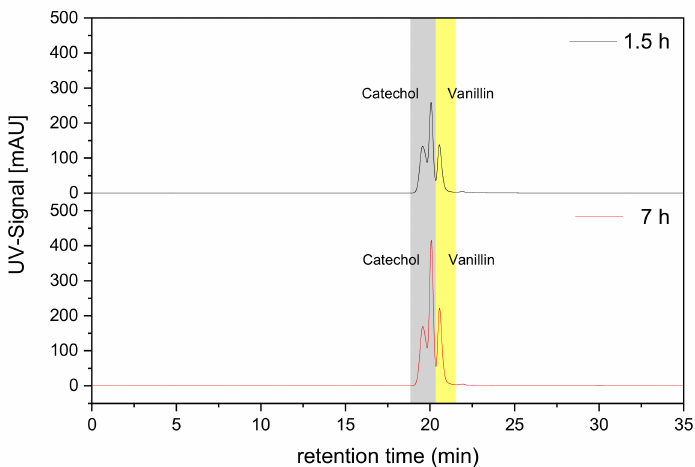
Figure 8. GPC spectra of the mixture vanillin-catechol in the receiving phase after 1.5 and 7 h. FP: mixture of both monomers with a concentration of 100 mg/L each one in citrate buffer pH 4; OP: 0.48 mol/L Cy923; RF: 0.50 mol/L